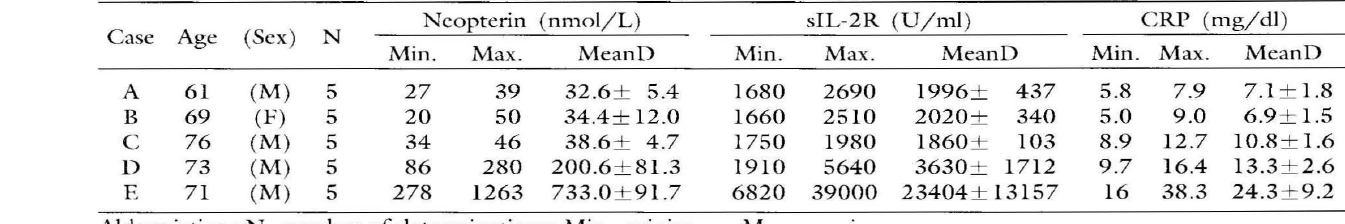
Table 1. Plasma neopterin, soluble interleukin-2 receptors (sIL-2R) and C-reactive protein (CRP) in patient~ with infections